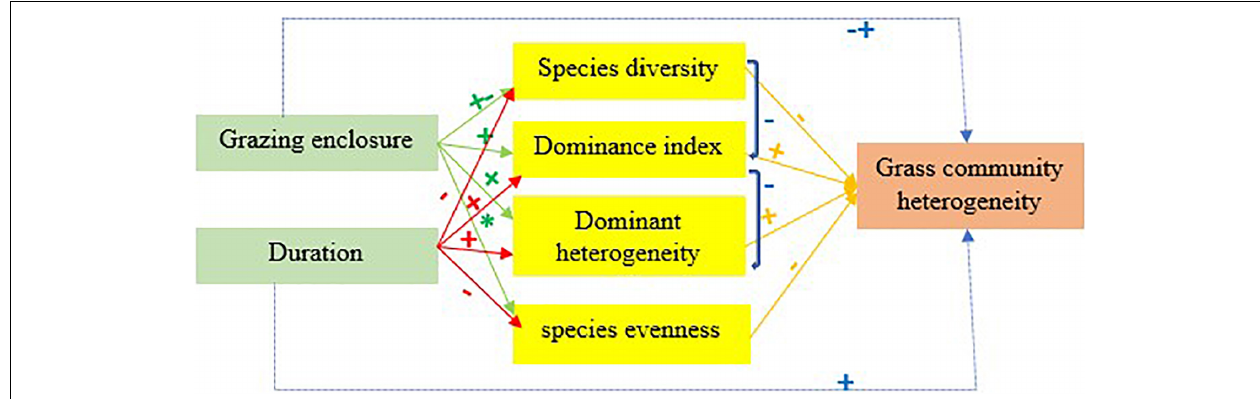
FIGURE 7 | A conceptual model of the effects of grazing enclosure and its duration of application on grass community spatial heterogeneity. Note. + and - signs across each arrow indicate significant positive and negative impacts, and * sign indicates non-significant